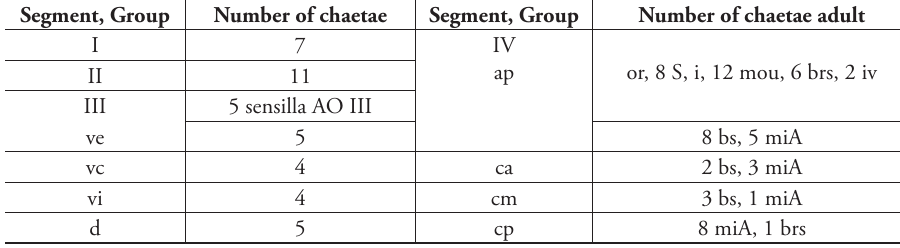
Table 1b. Chaetotaxy of Endonura longirostris sp. n.: chaetotaxy of antennae. Segment, Group